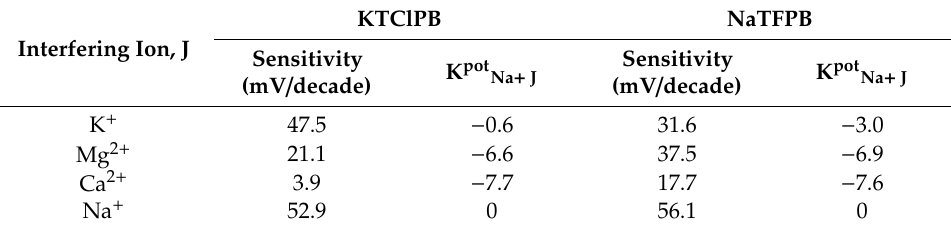
Figure 5. Wireless sodium detection with film ISEs. Photographs of circuit ( a ) before bending and ( b ) during 20° bending. ( c ) Voltage responses with different sodium concentrations for three cases: before bending (black line), during bending (red line), and after bending (green line). ( d ) Comparison of voltage responses, showing the role of additional polyvinyl butyral (PVB) membrane on RE.